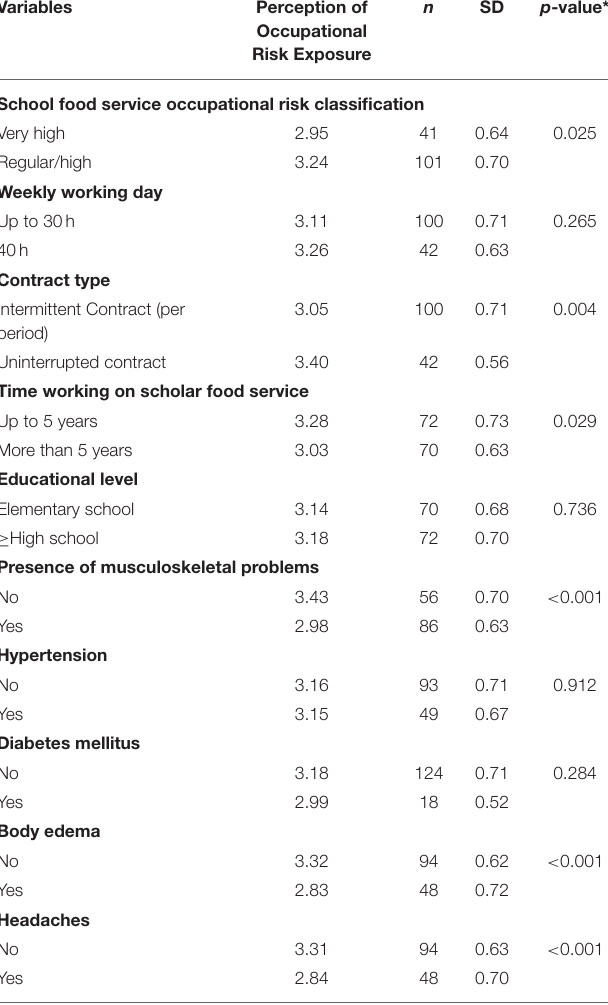
TABLE 6 | Health Risk and Occupational Risk classification variables of the scholar food services and the demographic characteristics, work, comorbidities with the mean of the food handlers’ Perception of Occupational Risk Exposure, number of workers, standard deviation, and p